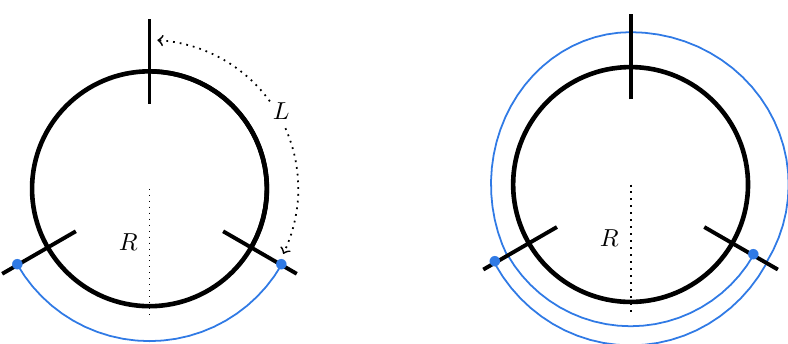
Figure 4. The circle of radius R represents the compactified X -direction and the ticks represent a series of D-branes transverse to the compactified circle, equidistantly positioned along X at x q = x 0 + q L , q = 0 , 1 , 2 , . . . , as shown in figure 2. The diagrams above depict the special case when 2 πR/L = 3 , which is rational. As a result, maximally, there are only three transverse branes in the circle. Note that these diagrams also represent the D-brane configuration when L takes other values, for example, L = 4 πR/ 3 . An open string, shown in blue, can stretch between two D-branes as in the left diagram, or as in the right diagram by making an integer number of wrappings around the compactified direction. Generically, when 2 πR/L is irrational, there is no maximal number of transverse branes in the